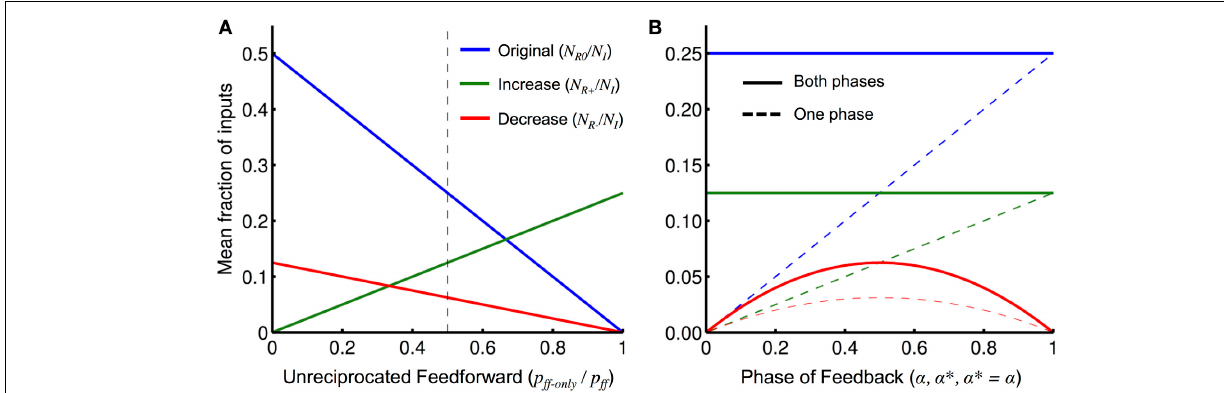
FIGURE 8 | Interaction effects with network parameters. (A) The mean fraction of relevant inputs (either phase) for an operation initiated alone, N R0 / N I (blue), and the mean increase and decrease in the fraction of relevant inputs (either phase) when feedback from a second operation or external unit is also present, N R + / N I (green) and N R − / N I (red), respectively, plotted as functions of the fraction p ff − only / p ff (the fraction of unreciprocated feedforward connections) as given by Equation (8). The values of other network parameters used were: p ff = 0 . 5, p fb = p ∗ fb = 0 . 5, and α = α ∗ = 0 . 5.